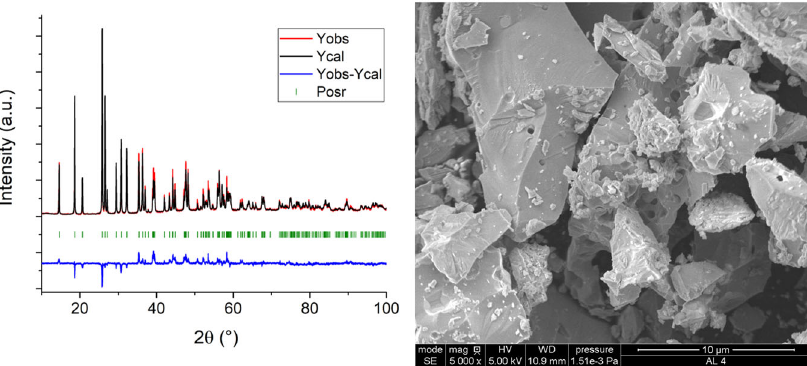
Fig. 8 PXRD and SEM images of as-prepared brannerite sample. Observed, calculated, and the difference patterns after the Rietveld re fi nement of the crystal structure of brannerite (left panel), SEM image of the brannerite grains used for the dissolution experiments (right